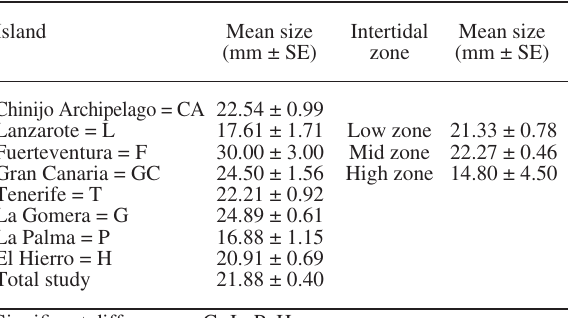
Fig . 3. − Size-frequency distribution of Stramonita haemastoma for the entire study area. Table 4. − mean sizes (mm SL ± Se) of Stramonita haemastoma at each island and in each intertidal zone (data pooled across islands). Table 3. − analysis of the variance components for each intertidal Significant differences in sizes, detected by 95% confidence inter- zone. The contribution of each factor ( ω ²) is presented as a percent- vals, are indicated as a footnote. age (%).